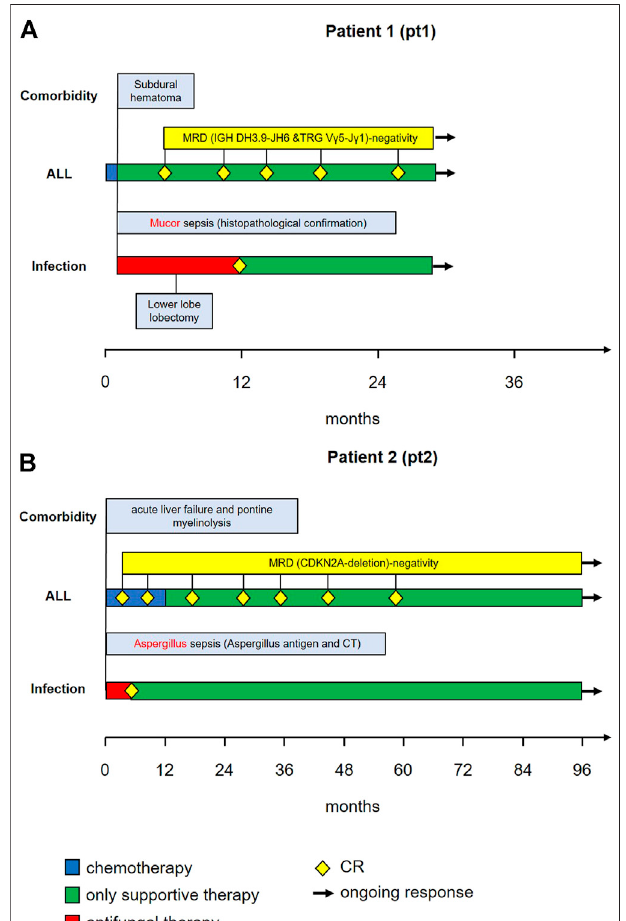
FIGURE 1 | Course of relevant comorbidities (1 st row), ALL treatment (2 nd row), fungal infection (3 rd row) and antimycotic treatment (4 th row) in Patient 1 (panel A) and Patient 2 (panel B)